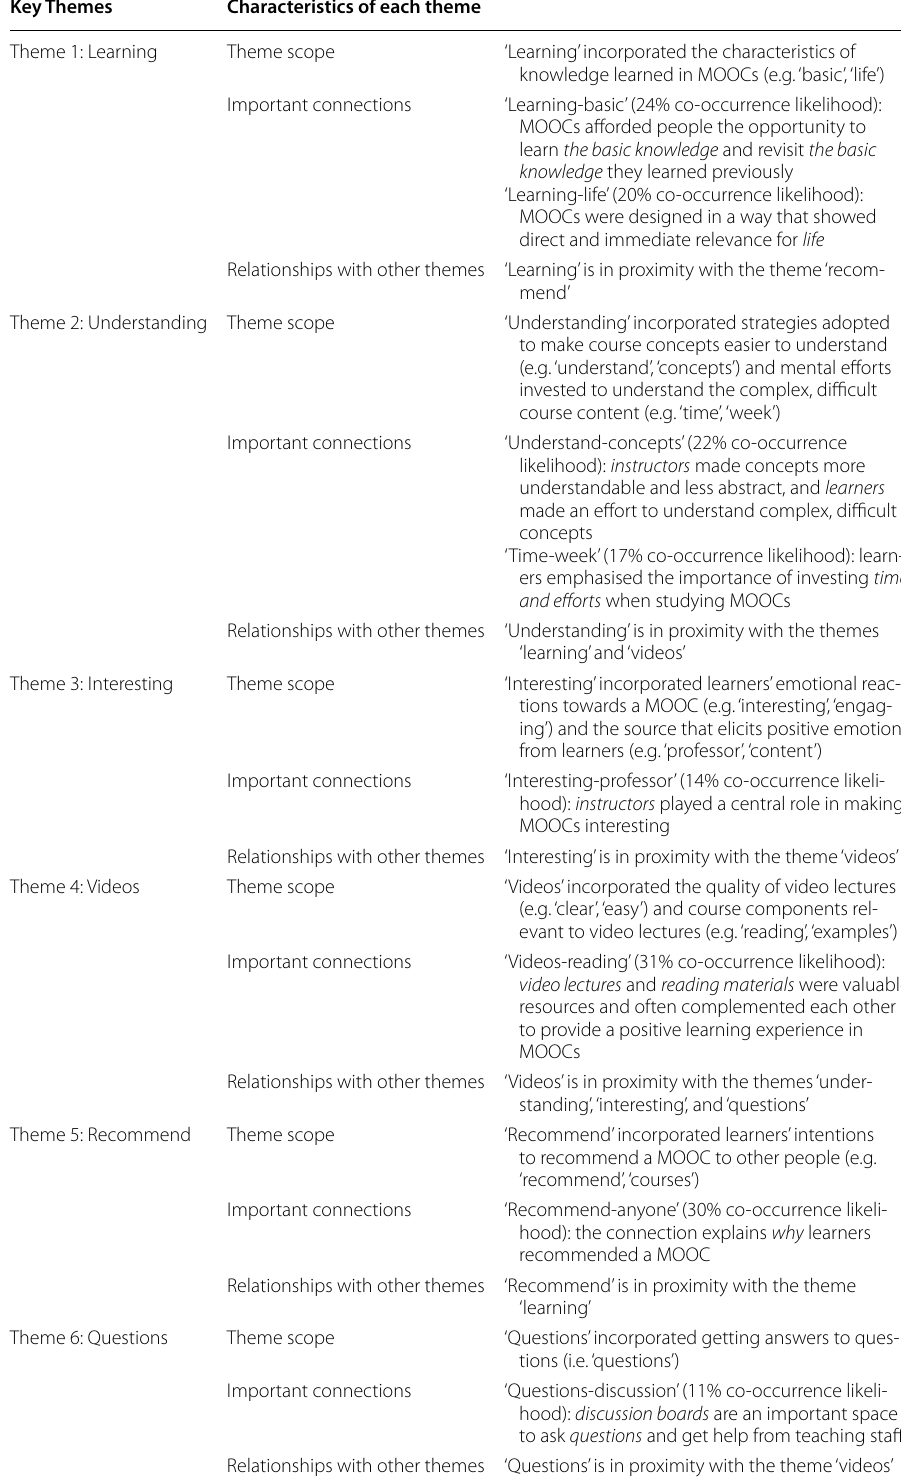
Table 5 Six key themes and their characteristics Key